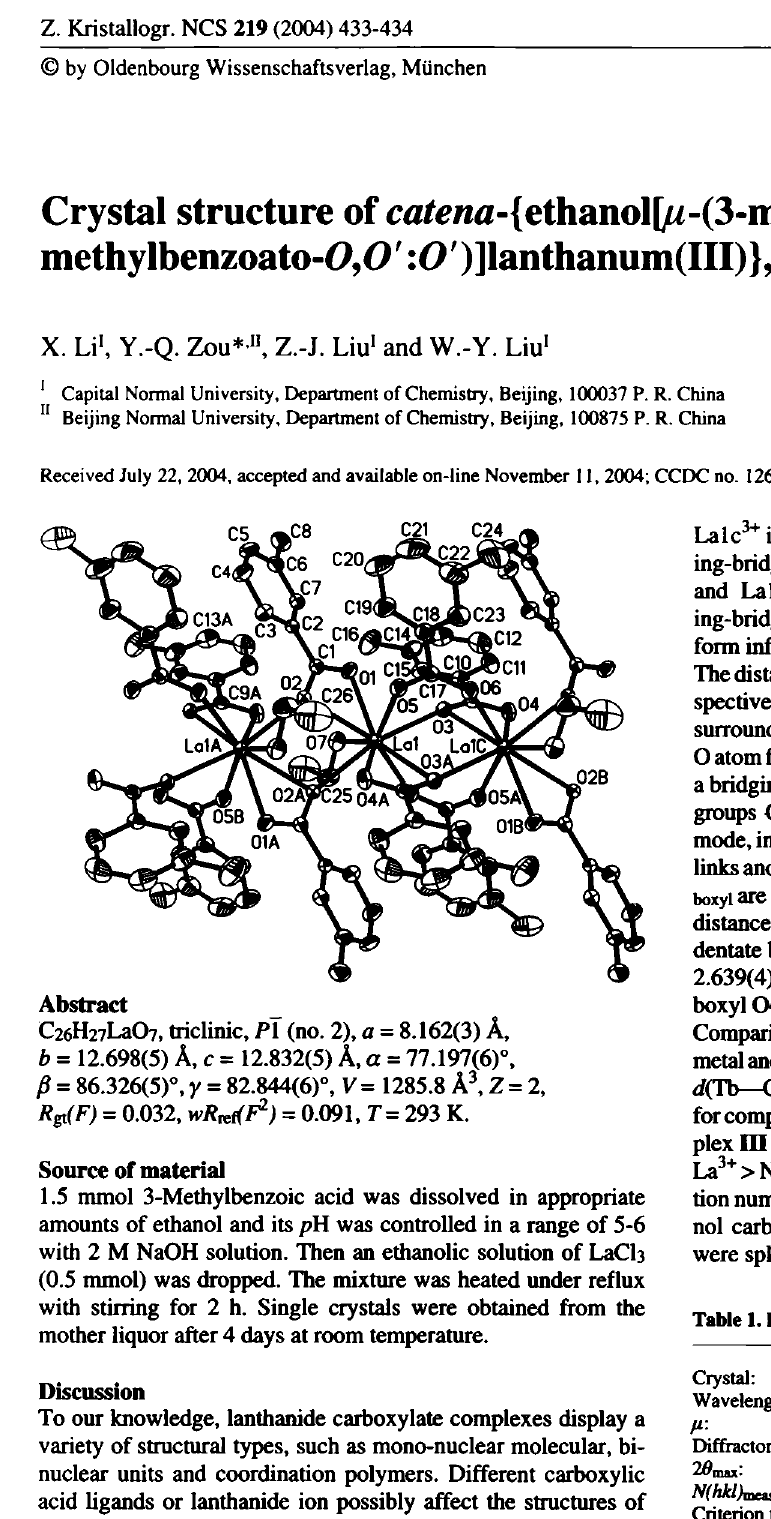
Table 2. Atomic coordinates and displacement parameters (in A 2